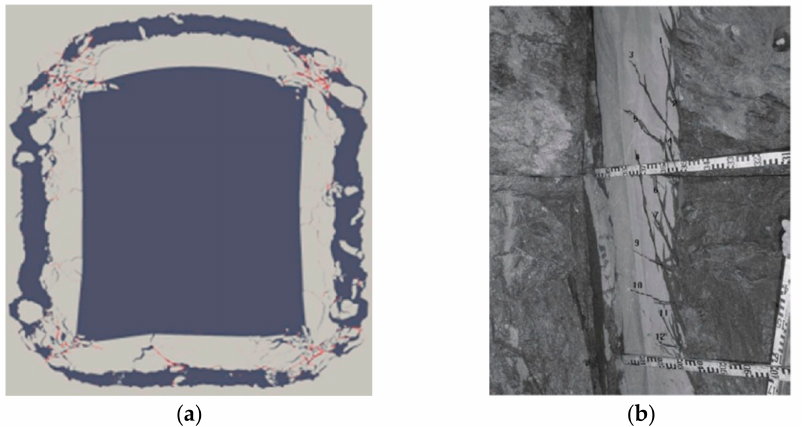
Figure 14. Tunnel crack propagation law: ( a ) other numerical simulation [46]; ( b ) field test results